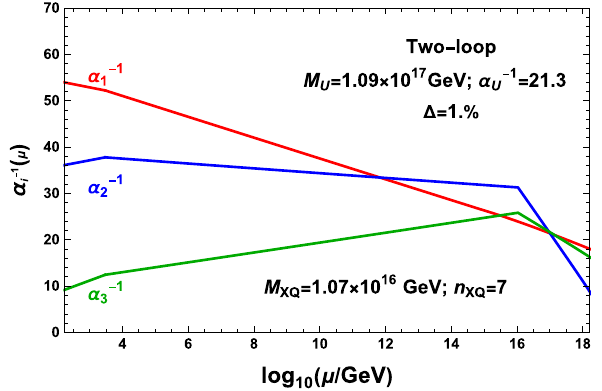
Fig. 3 Gauge coupling unification at 1 . 09 × 10 17 GeV for Model 3